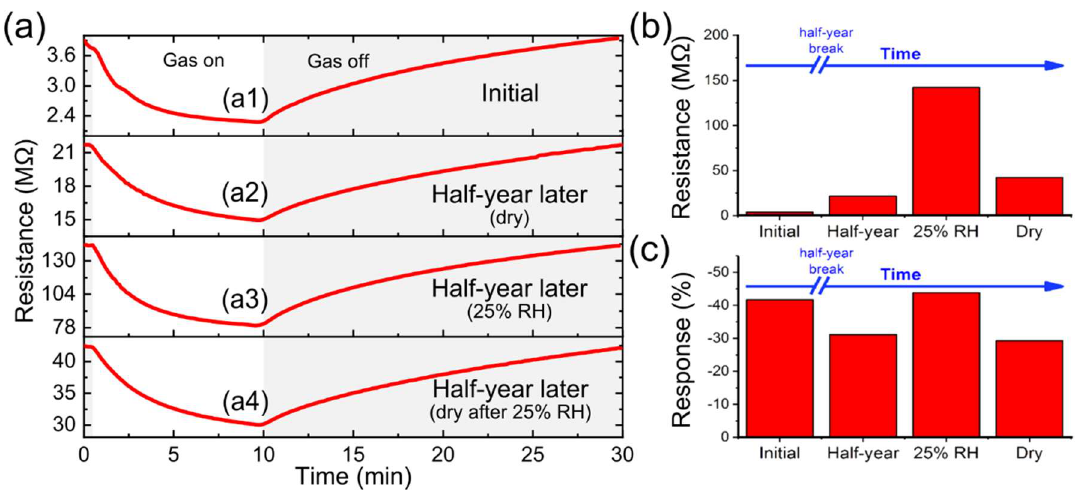
Figure 8. ( a ) Real time response of the sensor obtained with NO 2 sample at the concentration of 0.8 ppm ( a1 ) in a dry environment a few days later than the sensor fabrication, ( a2 ) in dry environment half a year later than the sensor fabrication, ( a3 ) in an environment with RH 25% at 23 °C, and ( a4 ) in the dry environment after humidity exposition. Values of ( b ) level of the sensor resistance and ( c ) sensor response under the different operating conditions.